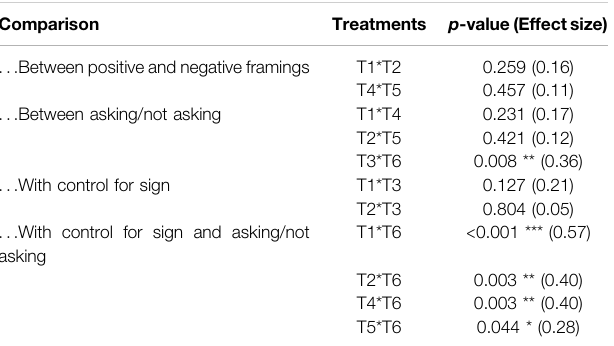
TABLE 2 | Proportion test results of refused plastic